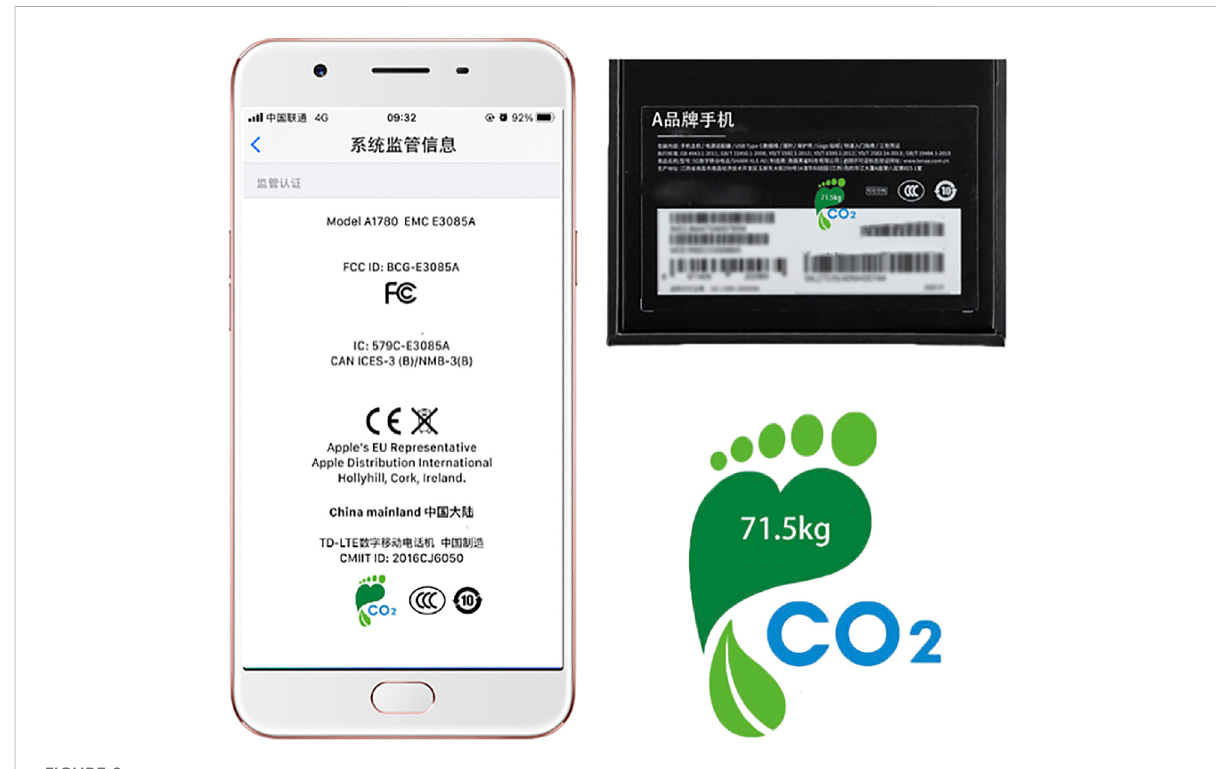
FIGURE 2 Design of picture materials in the